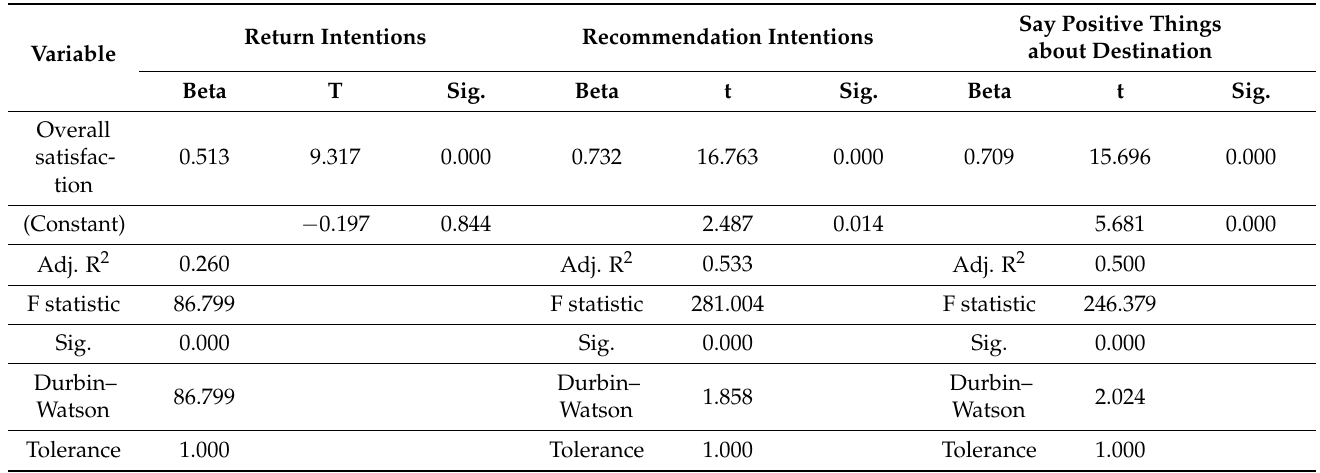
Table 5. Relationship of general satisfaction with the loyalty